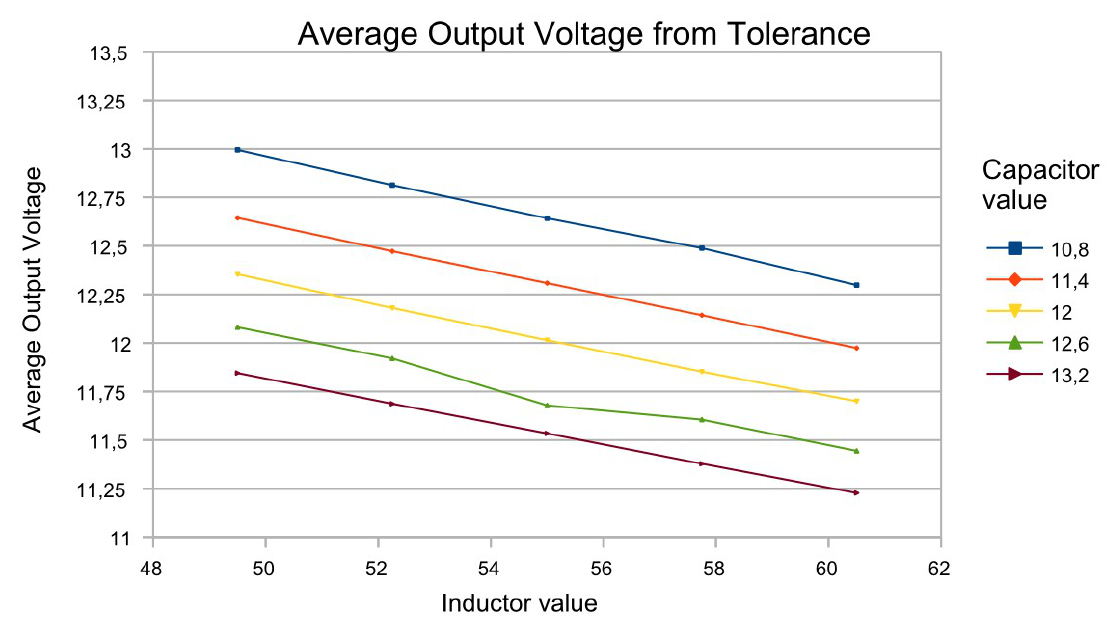
Figure 4. Tolerance analysis of the average output voltage.